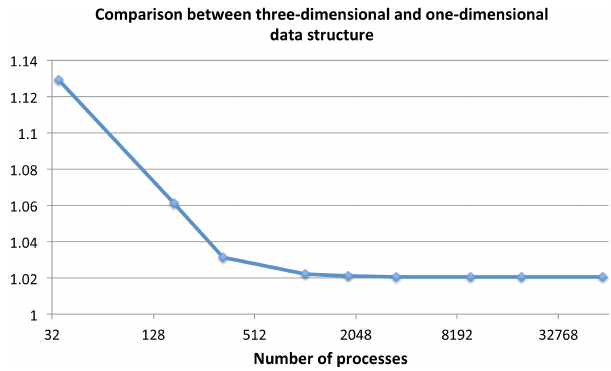
Figure 9. Ratio between the number of floating point operations when using the three-dimensional and one-dimensional data struc-